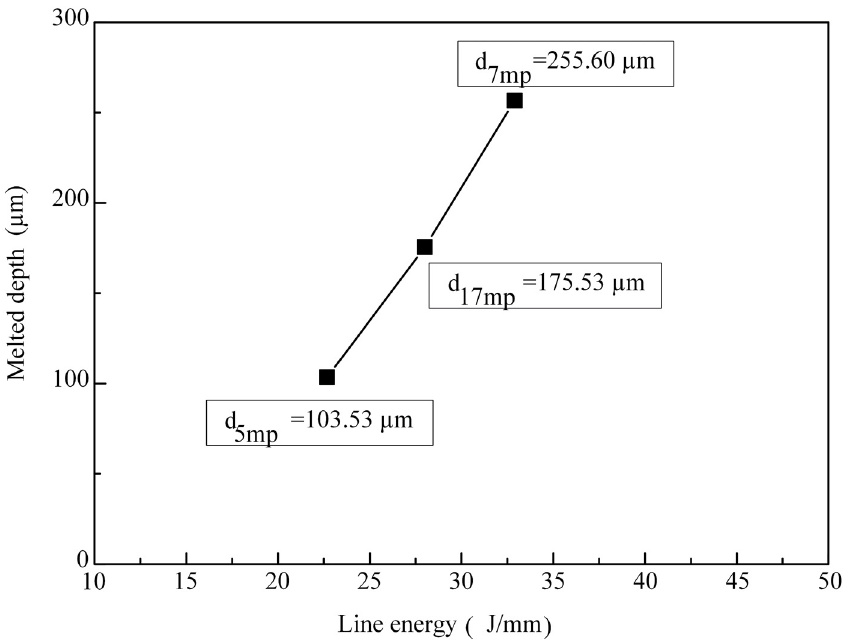
Figure 8. Relationship between the melted depth and laser line energy for typical samples (NO.5, NO.7, and NO.17). NO.7, and